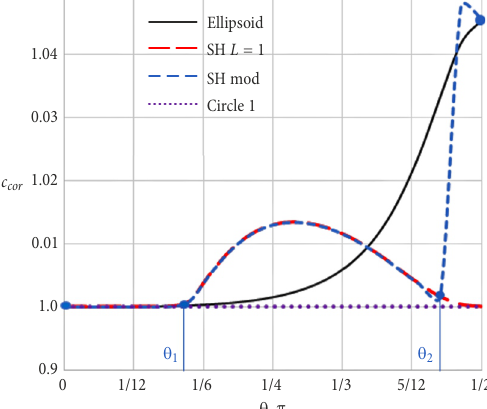
Fig. 9. Variations of correction factor c contact in longitudinal section